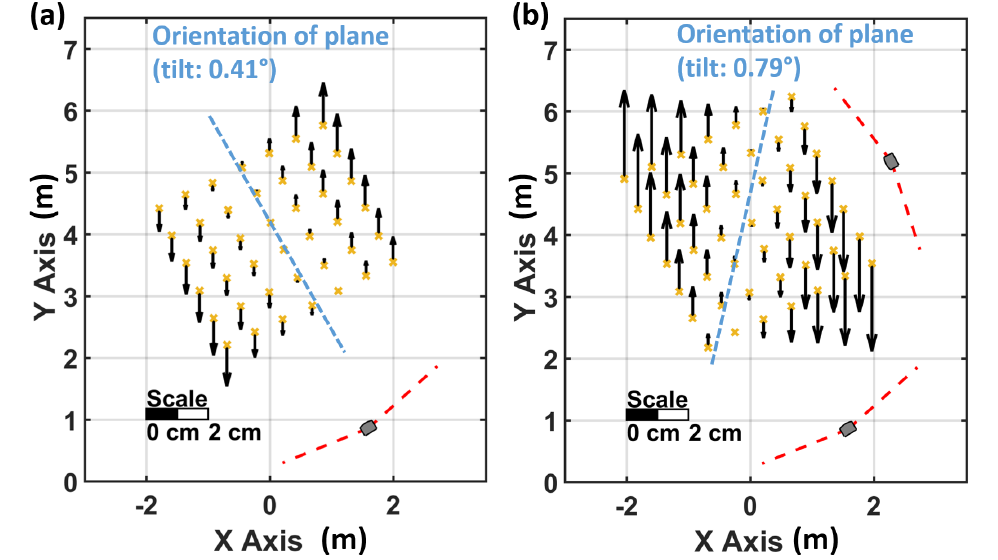
Figure 8. Height deviations to total station measurements with ( a ) one and ( b ) two